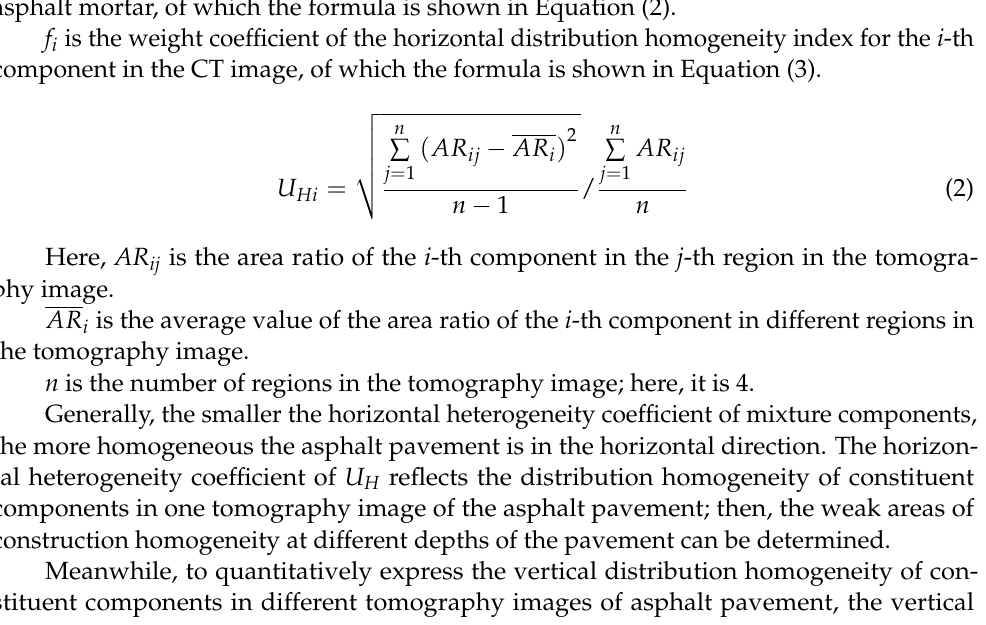
Figure 13. The region division of CT image. (I – IV respectively refers to the first to fourth regions of CT image.)